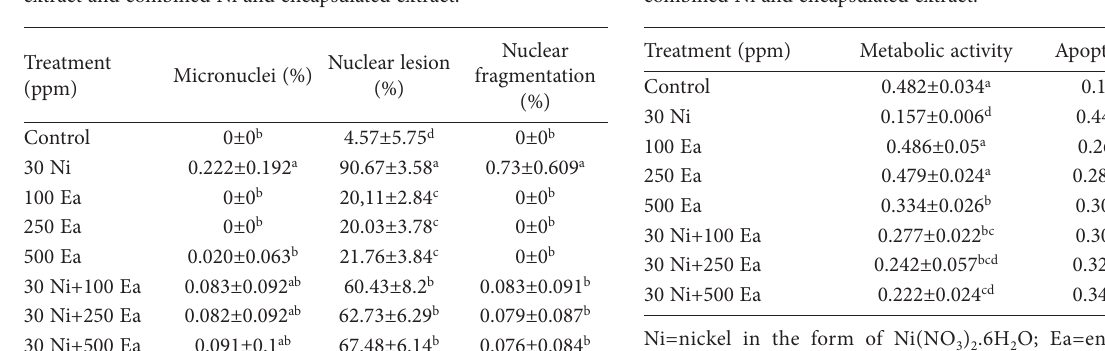
Table 4. The percentages of nuclear abnormalities of A. cepa root tip cells after treatment with Ni, encapsulated E. acoroides leaves extract and combined Ni and encapsulated extract.